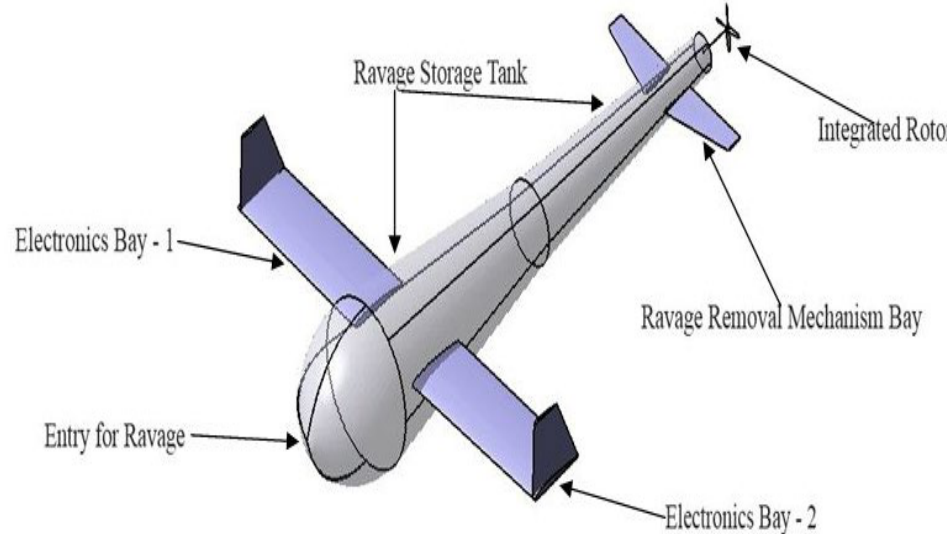
Figure 41. Components and arrangements of UAV at the stage of collection of ravage.